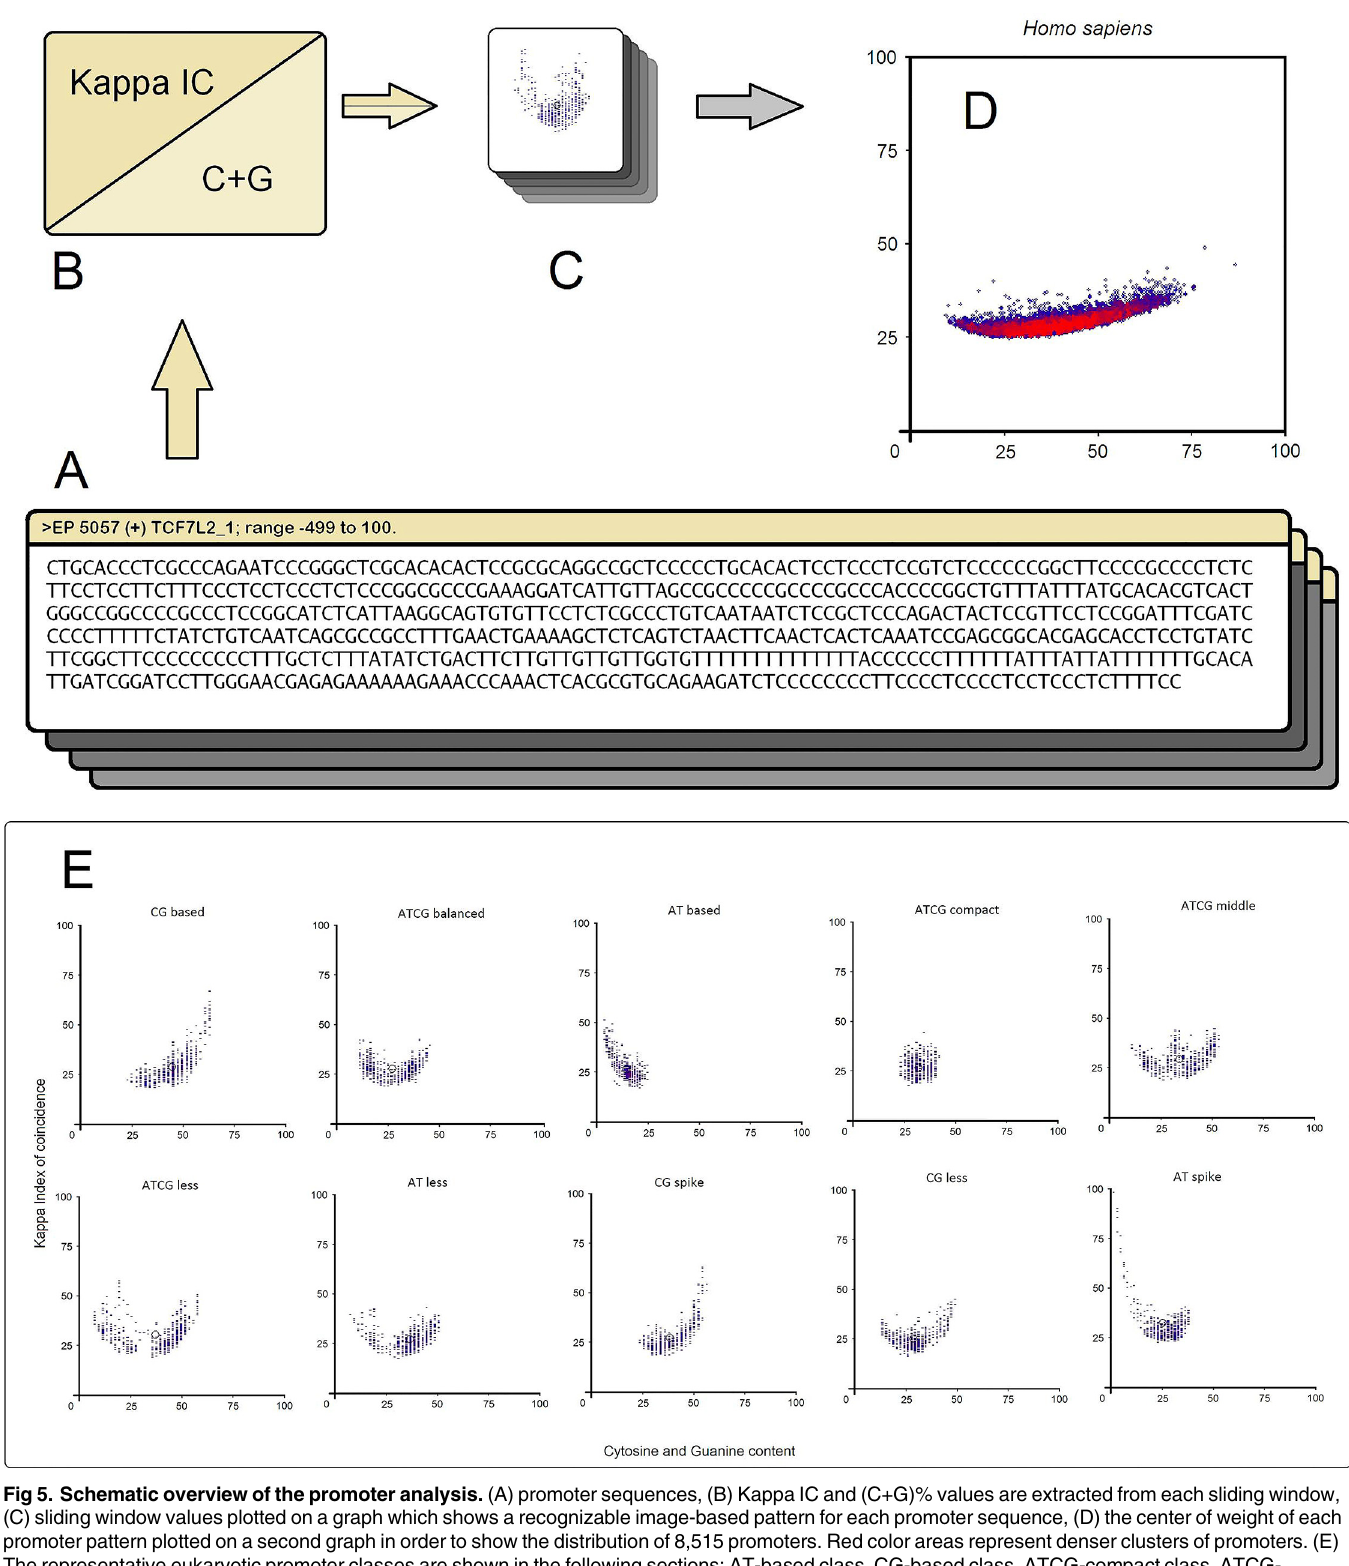
PLOS ONE | DOI:10.1371/journal.pone.0137950 September 17,